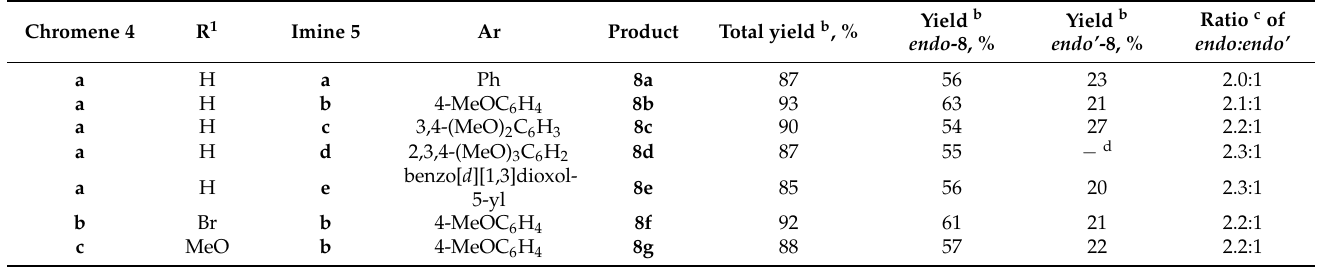
Table 2. Scope of the synthesis of 4-Ph-substituted chromeno[3,4- c ]pyrrolidines 8 a . Chromene 4